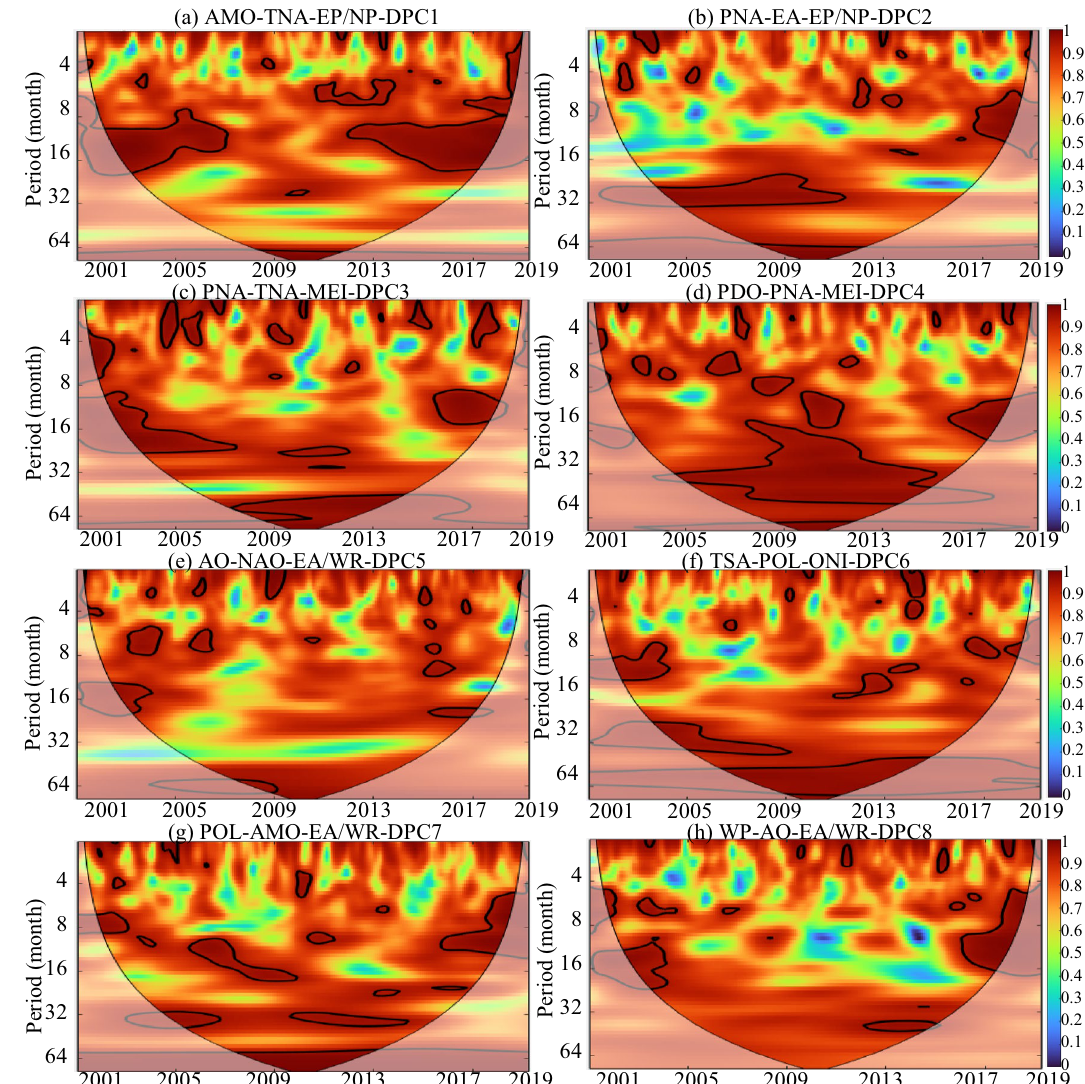
Figure 9. Three-factor multiple wavelet coherence between the top three global climatic drivers and the temporal patterns of DPC1–8. The black contour designates the 95% confidence level against red noise, and the COI, where edge effects might distort the picture, is shown as a lighter, paler shade. In addition, the phase lags are illustrated by black arrows. The y-axis represents the coherence period, and the color represents the level of the coherence coefficient. This figure was generated using MATLAB version R2020b (https:// jp. mathw orks. com/). The data used in the calculation comes from Fire CCI v5.1 dataset (https:// geogra. uah. es/ fire_ cci/ firec ci51. php) and NOAA (https:// psl. noaa. gov/ data/ clima teind ices/